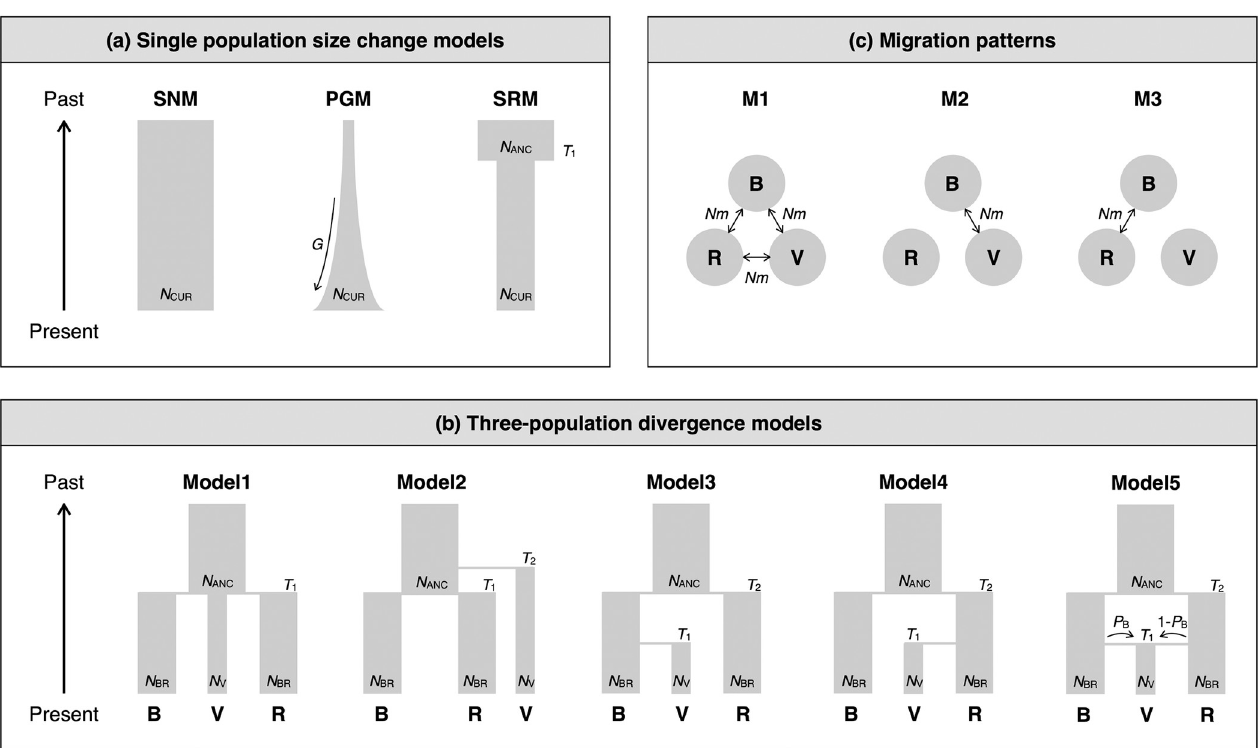
Fig 2. Population demographic models. Three single population size change models (a; SNM, standard neutral model; PGM, population growth model; SRM, size reduction model). Five three-population divergence models (b; B, Bonin group; V, Volcano group; Y+D, Yaeyama and Daito group). Three migration patterns